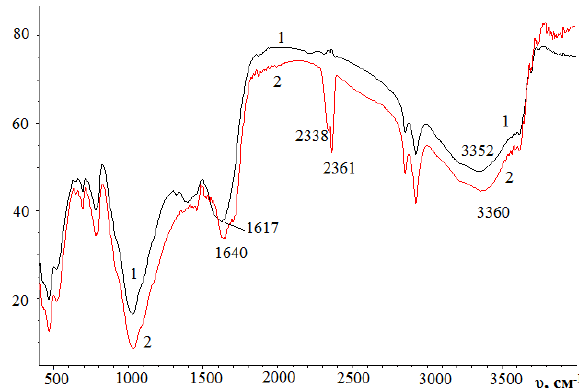
Figure 7: IR-spectrum of humic sorbent: 1 - before sorption; 2 - after sorption of